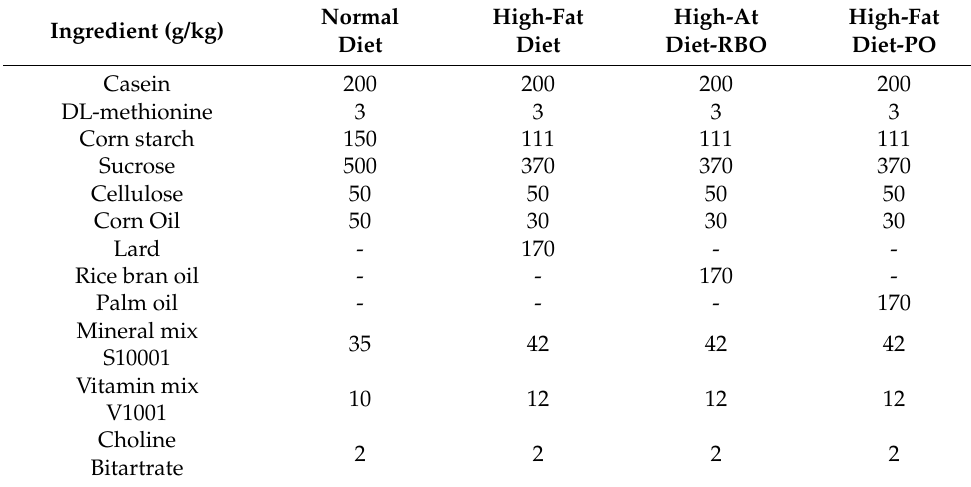
Table 1. Experimental diet composition.